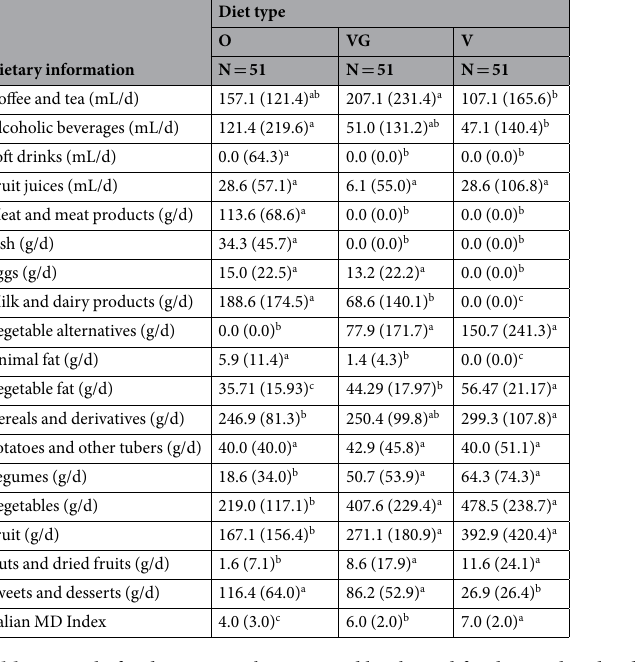
Table 2. Daily food group intakes assessed by the 7-d food record and Italian Mediterranean Index for each of the three diet groups. Values are median (interquartile range) of fifty-one independent measurements. Different letters indicate significantly different values ( P < 0.05) as calculated by non-parametric Kruskal-Wallis test with pairwise multiple comparisons. MD, Mediterranean diet; O, omnivores; VG, ovo-lacto-vegetarians; V,